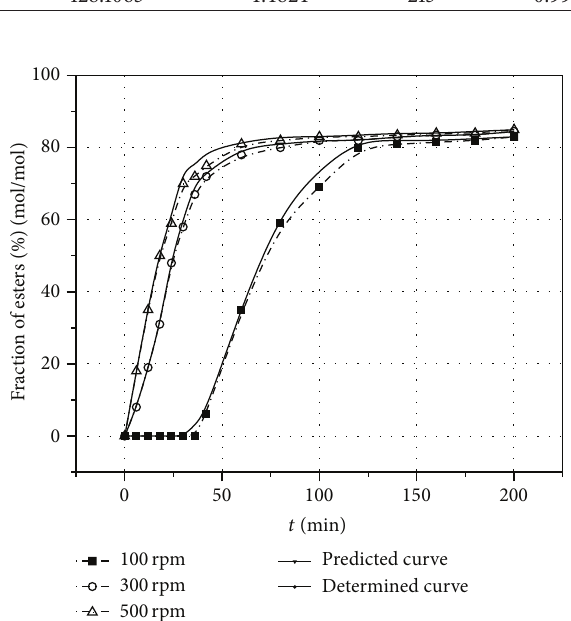
Figure 2: Effect of mixing intensity on the oil conversion into methyl